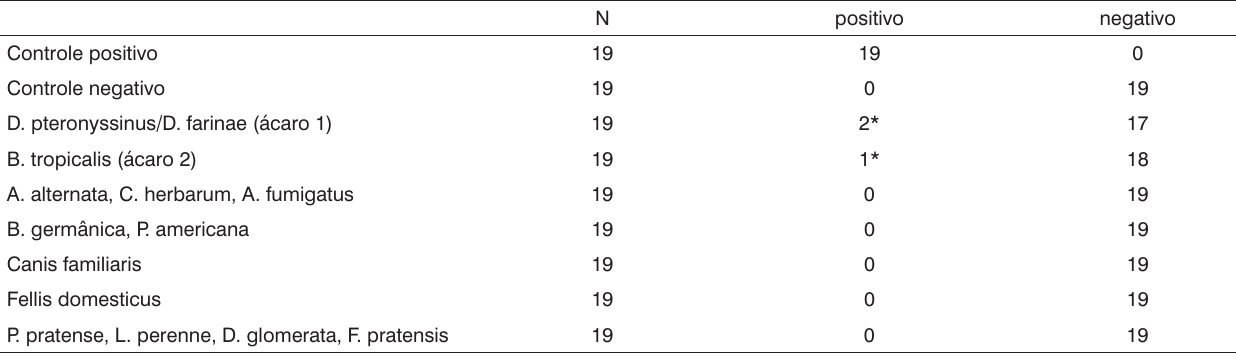
Tabela 2. Resultados encontrados no Teste Cutâneo de Hipersensibilidade Imediata